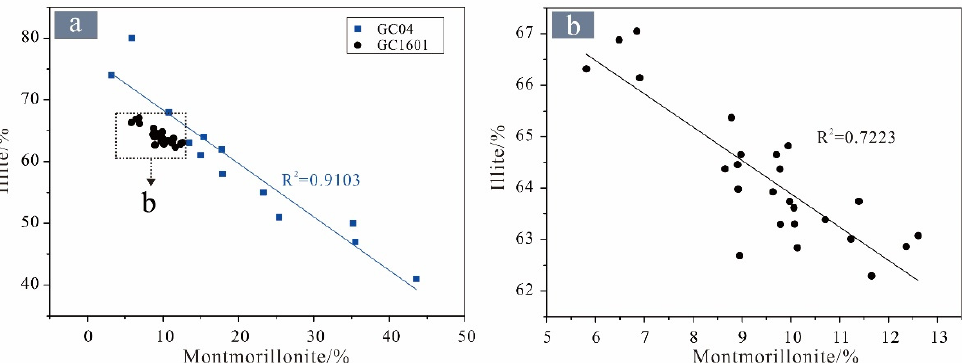
Figure 7. Correlation between montmorillonite and illite in GC04 and GC1601, ( a ) montmorillonite– illite, the area highlighted by the black dotted rectangle with the letter b is shown in ( b ).